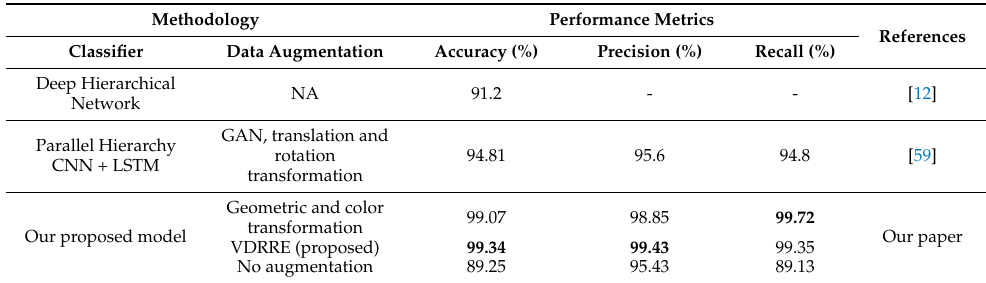
Table 3. Comparison of results with related work. Best values are shown in bold. CNN, deep convo- lutional neural network; LSTM, long short-term memory; GAN, generative adversarial